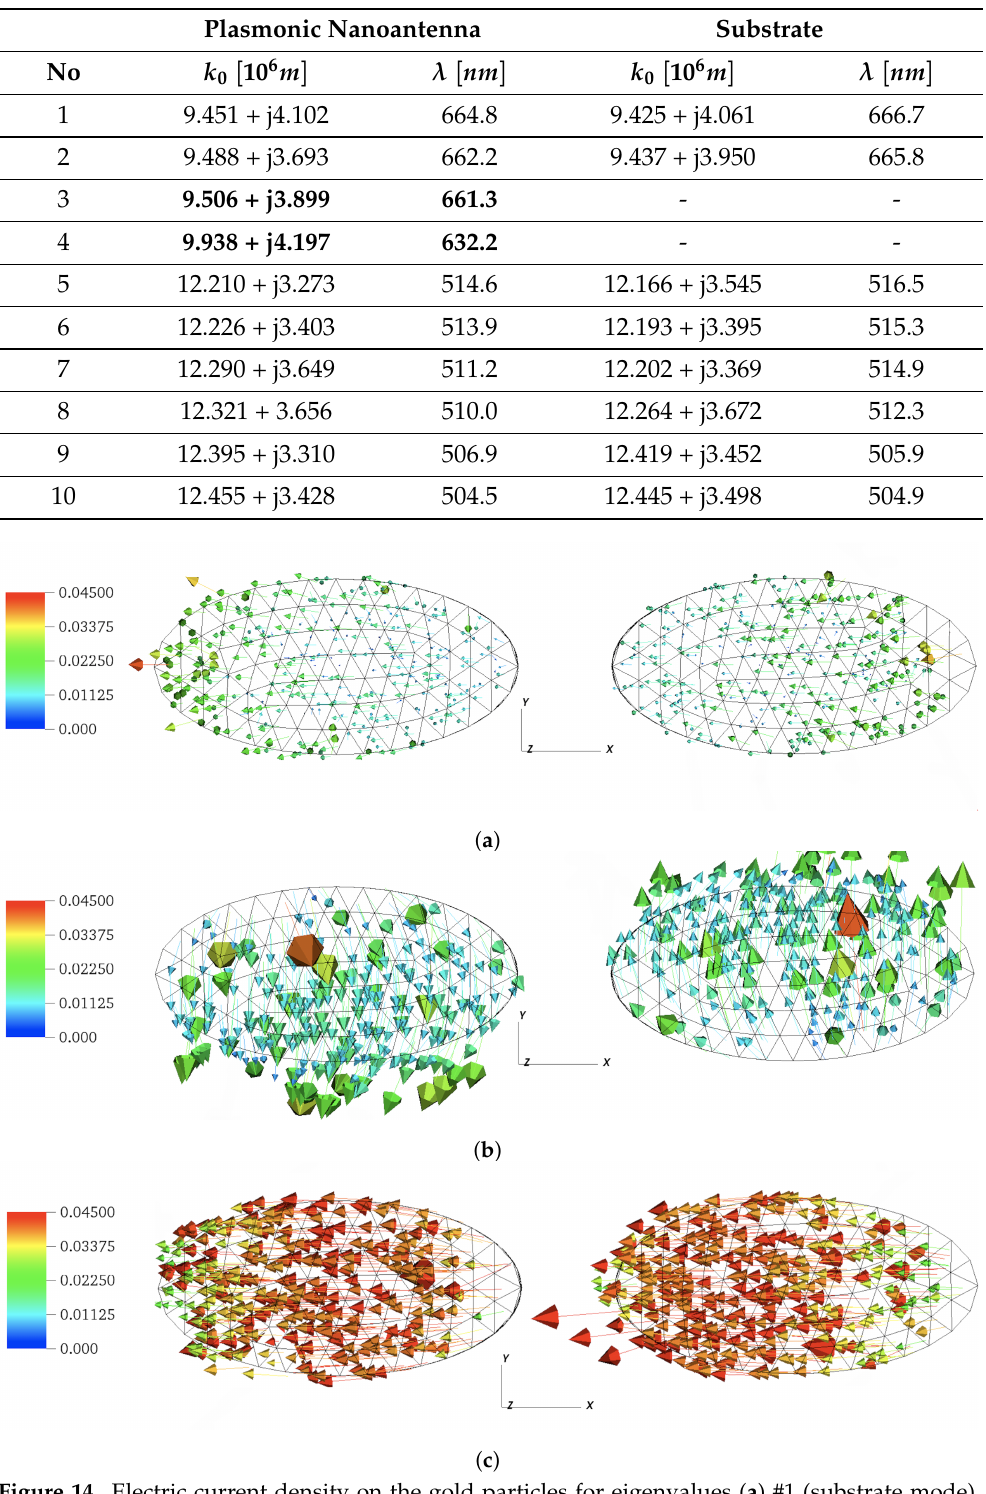
Table 2. Ten first eigenvalues and corresponding resonant wavelengths for the plasmonic nanoan- tenna (see Figure 13) using the auxiliary field-based formulation (Section 2.2.2). The last two columns refer to the eigenvalues and corresponding resonant wavelengths of the substrate (absence of gold particles). The eigenvalues appearing in bold (3,4) correspond to patch antenna modes.